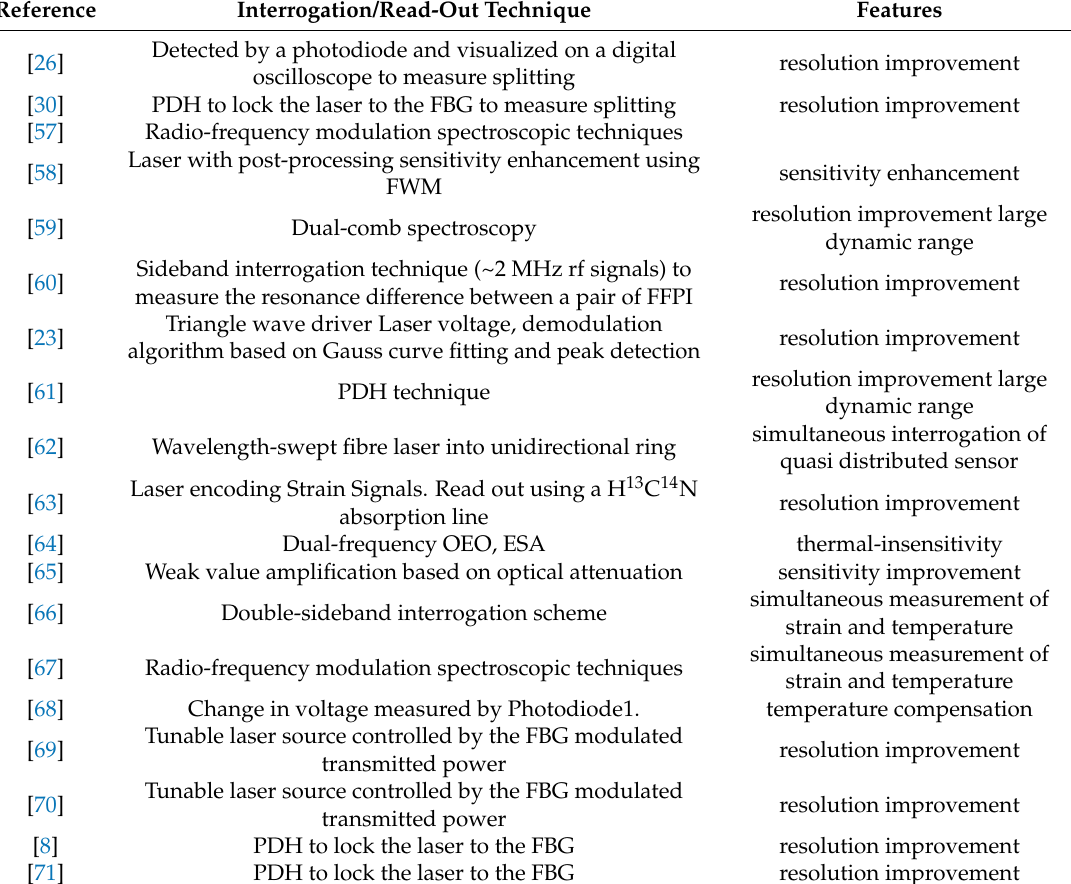
Table 2. Interrogation/read-out